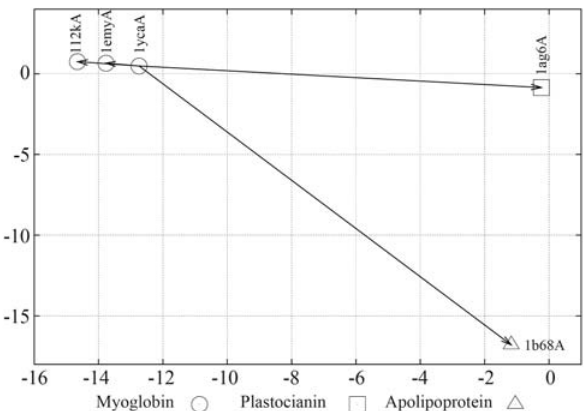
Figure 5 - A two-dimensional plot of documents and the query from this sample dataset.